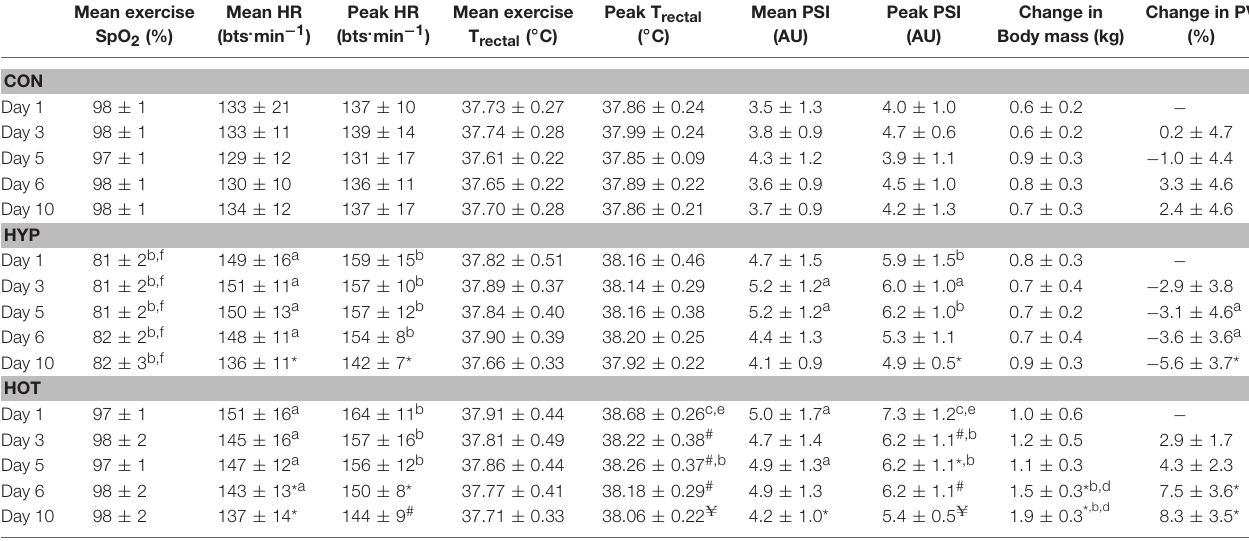
TABLE 1 | Mean and peak exercise physiological responses throughout the 10-day acclimation period in the CON ( n = 7), HYP ( n = 7), and HOT ( n = 7) experimental groups. Mean PSI Peak PSI Change in Change in PV Mean exercise Mean HR Peak HR Mean exercise Peak T rectal ( ◦ C) (AU) (AU) Body mass (kg) SpO 2 (%) (bts . min − 1 ) (bts . min − 1 ) T rectal ( ◦ C)